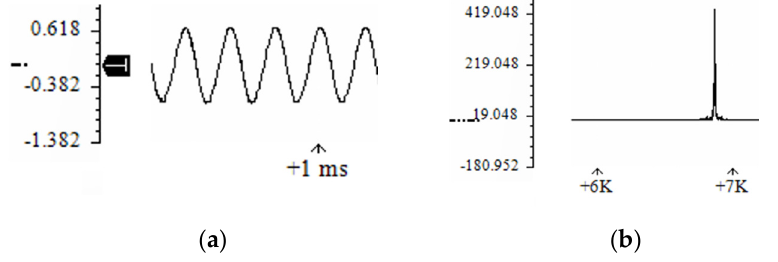
Table 3. Test conditions at maximum power.